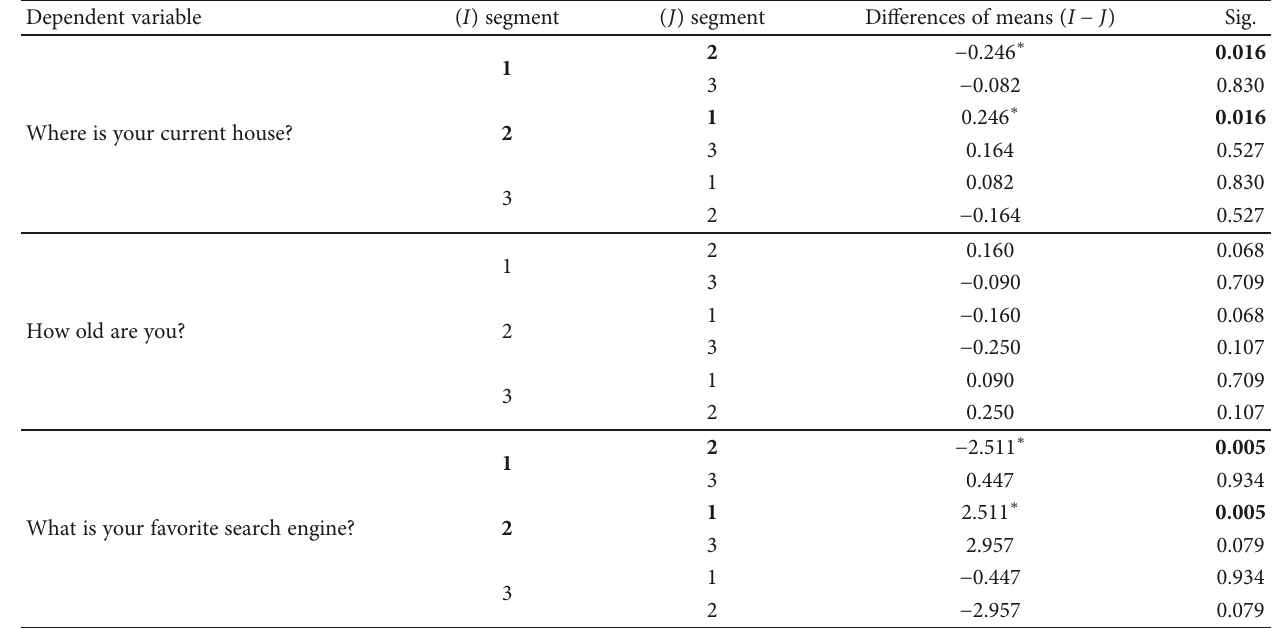
Table 10: ANOVA di ff erences of means for segments.